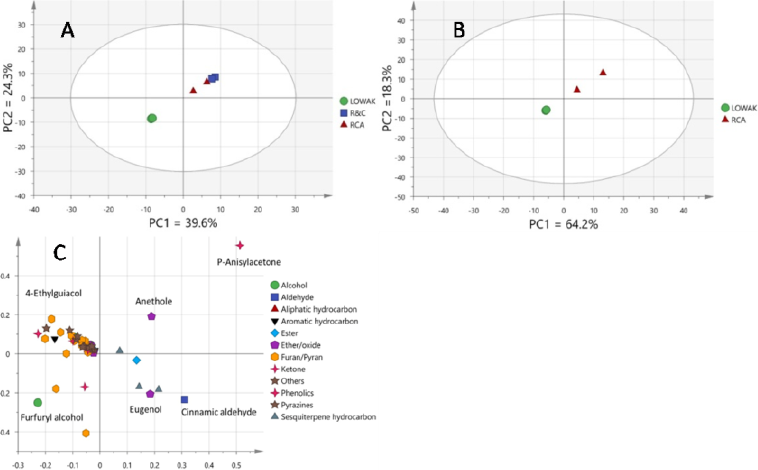
Figure 5. ( A ) PCA model score-plot of the Luwak coffee samples, along with commercially roasted coffee with cardamom and authentically roasted C. arabica . ( B ) PCA model score-plot of the Luwak coffee samples, along with authentically roasted C. arabica . ( C ) PCA loading plot of the Luwak coffee samples (LUWAK) versus authentically roasted C. arabica (RCA).